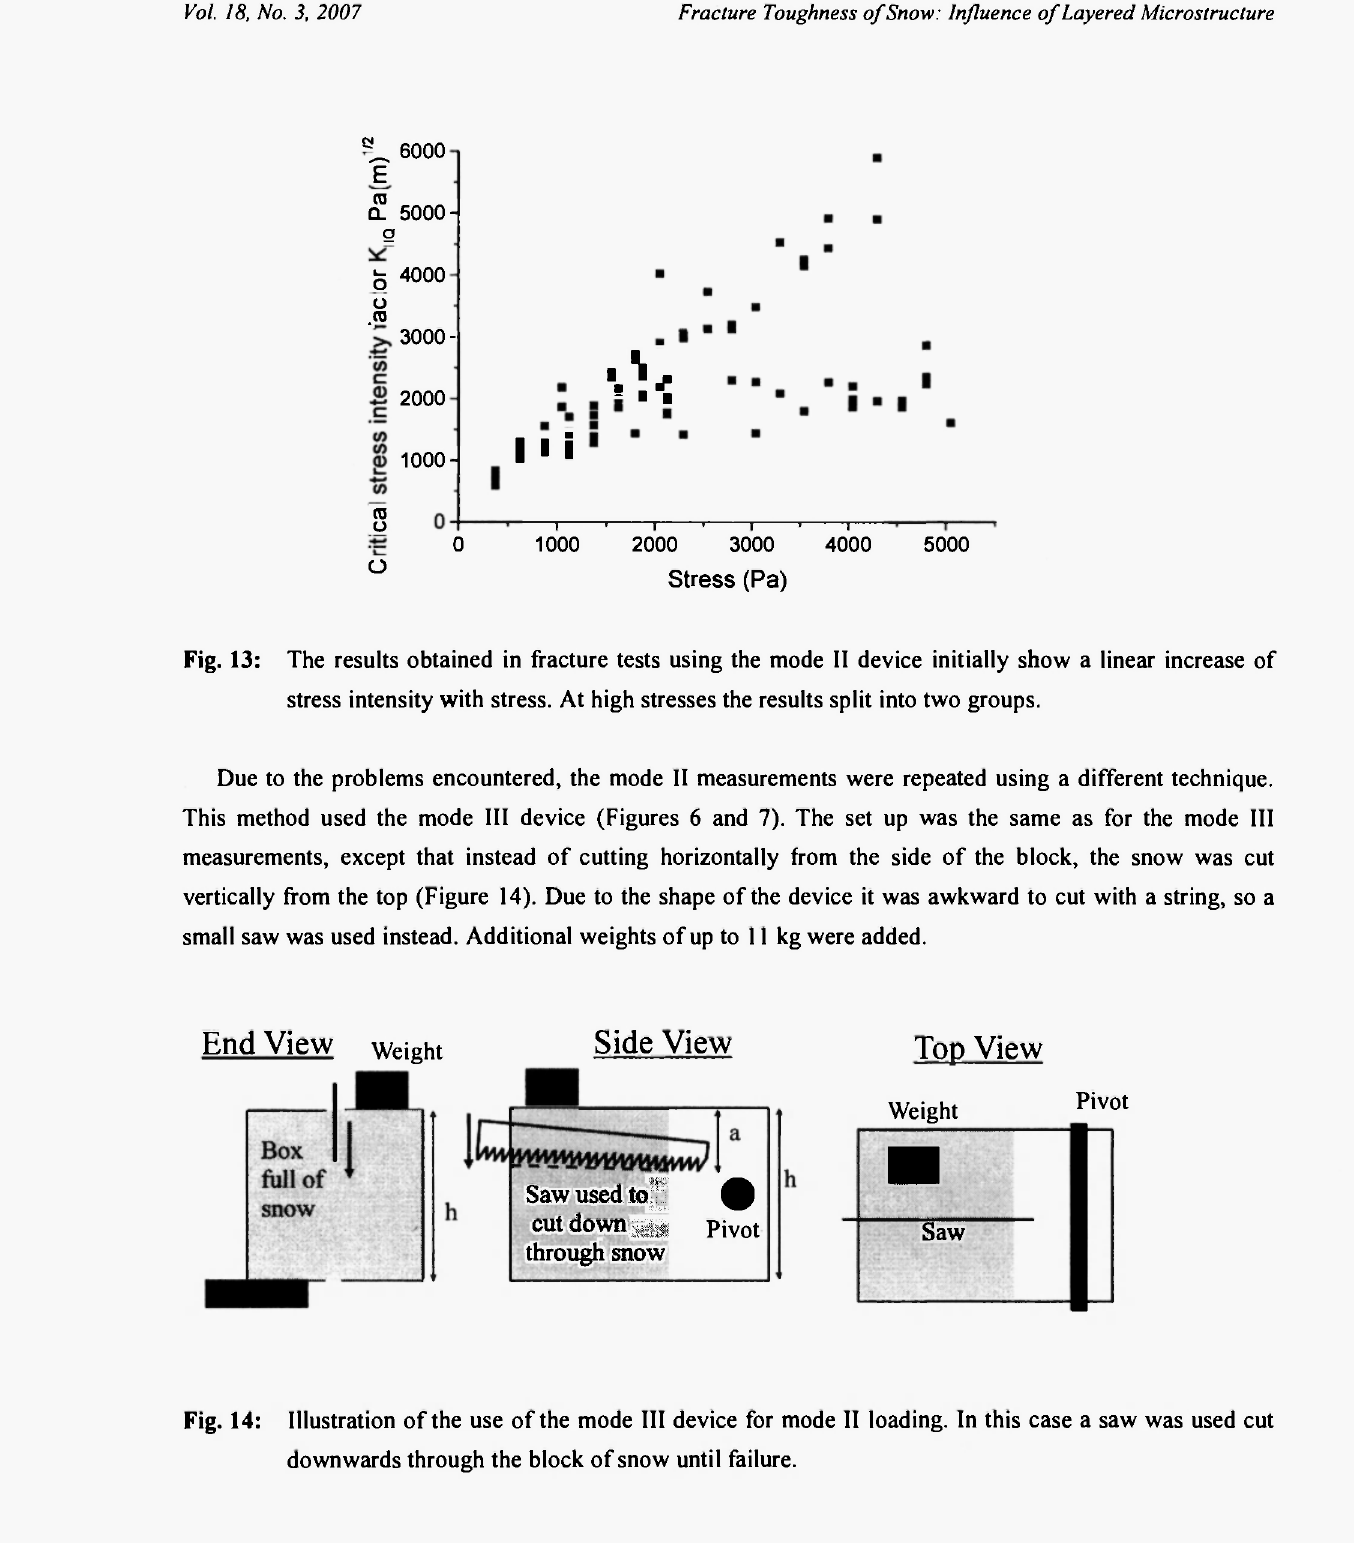
Illustration of the use of the mode III device for mode II loading. In this case a saw was used cut downwards through the block of snow until